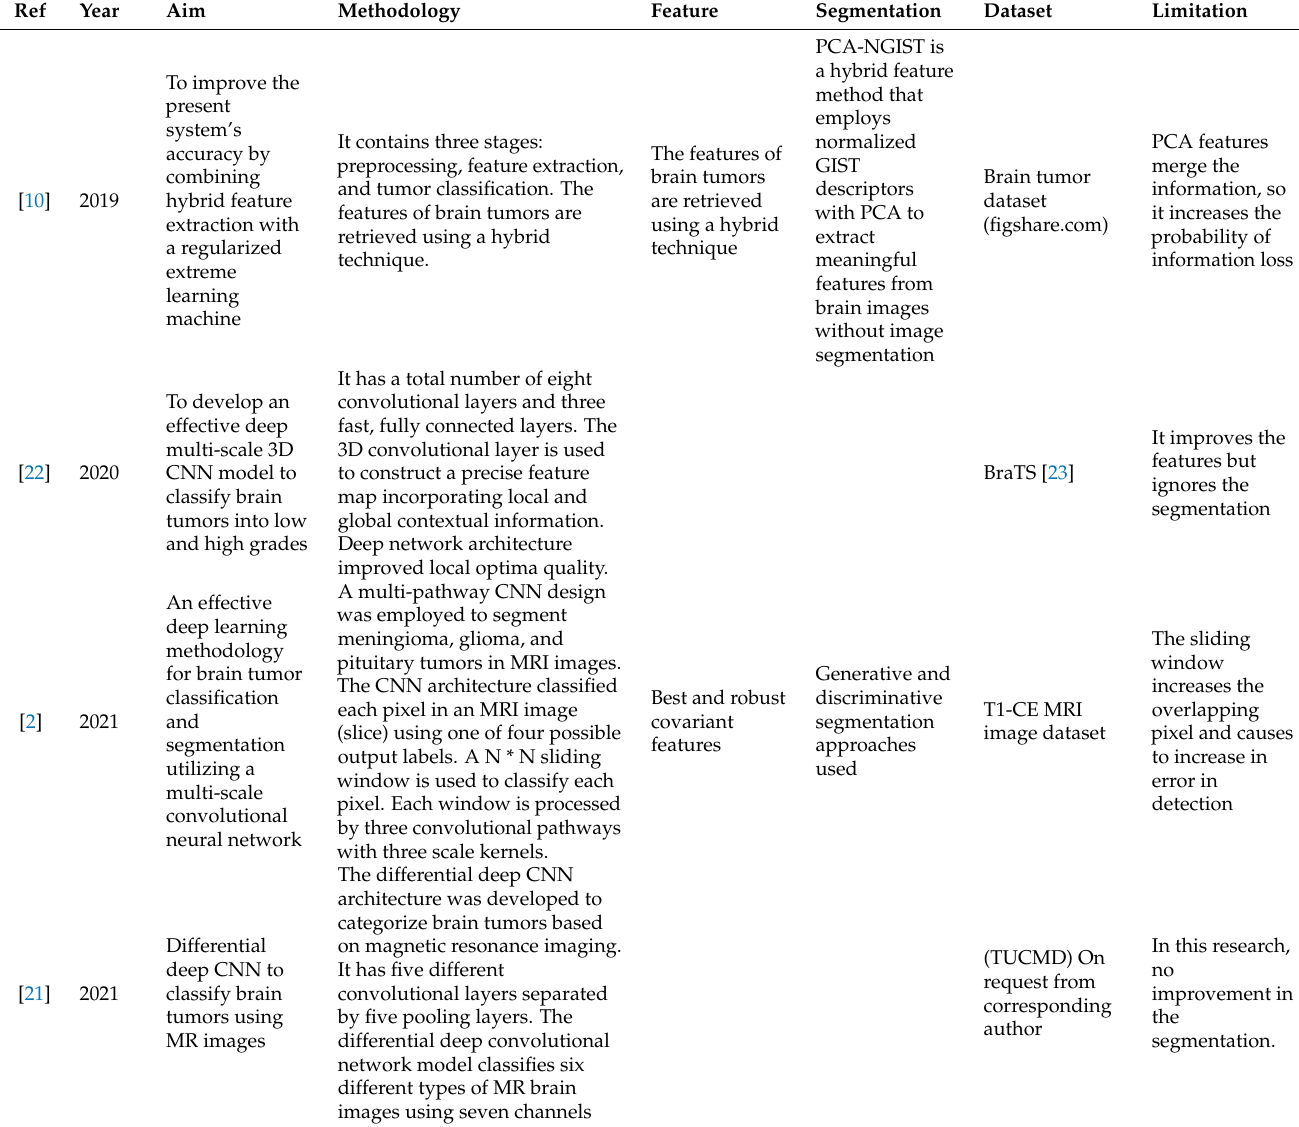
Table 1. Study of recent related work related to brain tumor